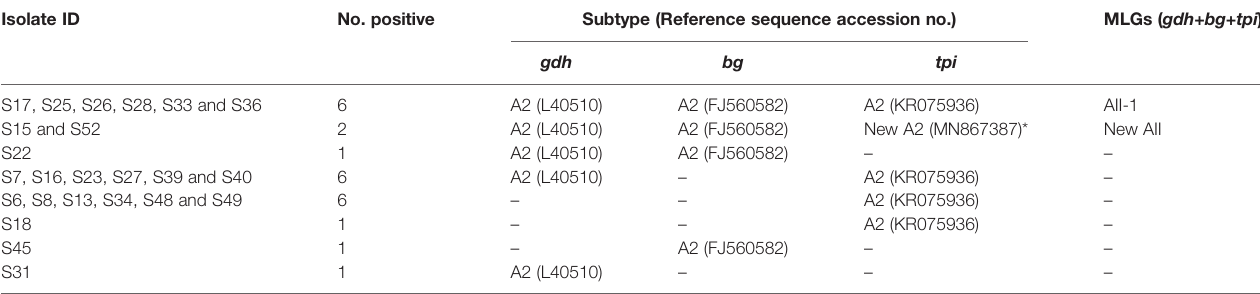
TABLE 4 | Multilocus sequence types of G. duodenalis sub-assemblage AII isolates. Isolate